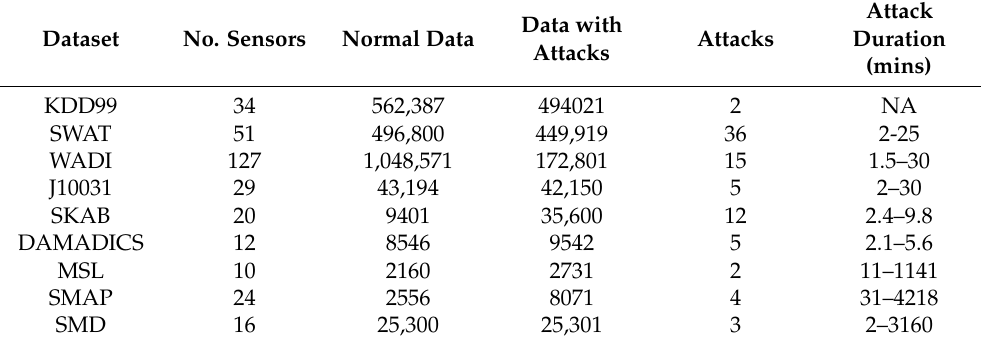
Table 4. The details of